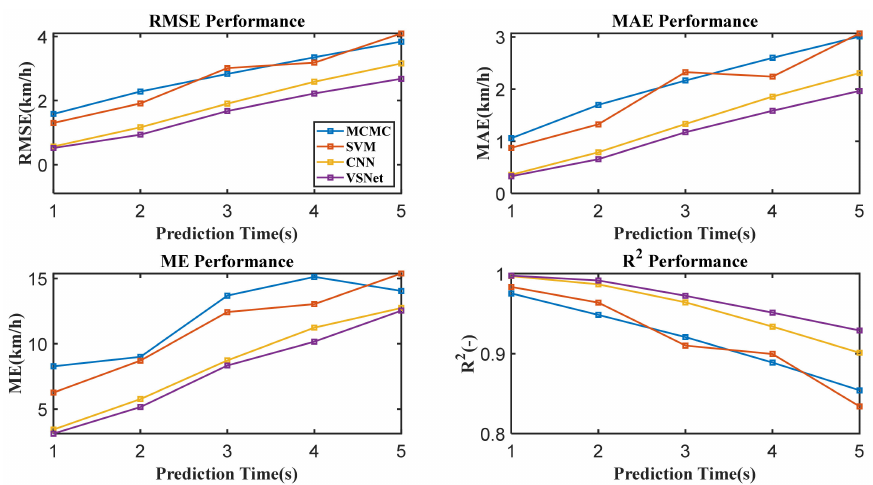
Figure 18. The performance of the four methods. The black line in Figure 9 is the actual vehicle speed for the test driving cycle. Each colored line is the prediction result of vehicle speed for the next 5 s corresponding to